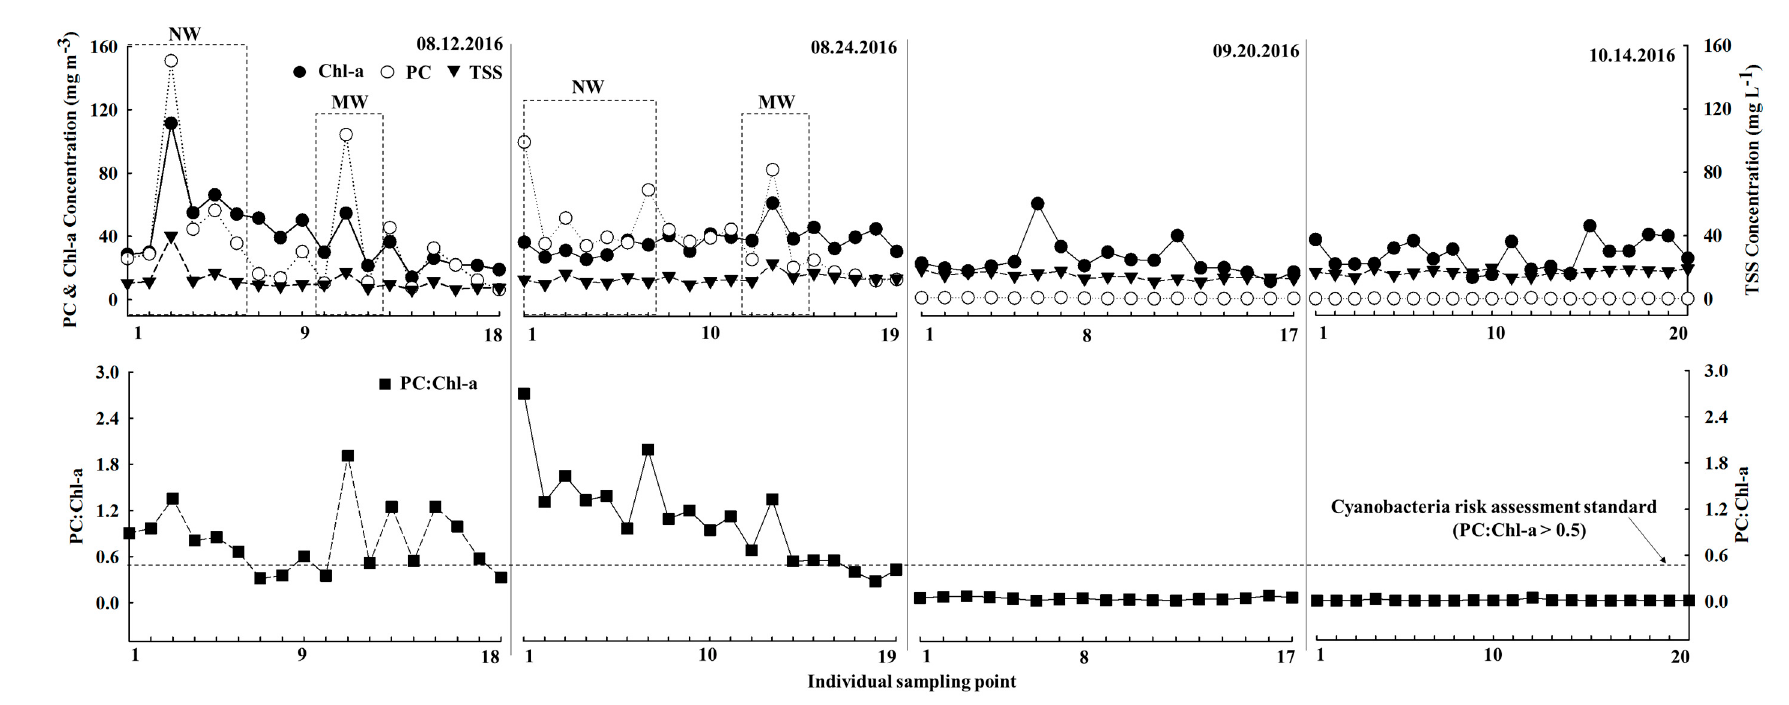
Figure 3. Variation in PC, Chl-a, TSS, and PC:Chl-a in the Baekje Reservoir. NW indicates sampling points near Baekje Weir and MW indicates sampling point in the middle of Baekje Weir.